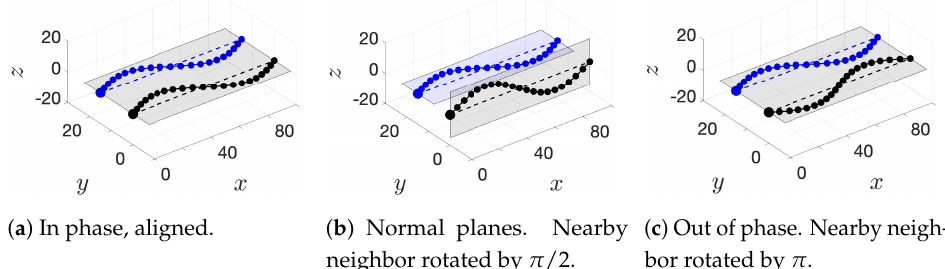
( a ) In phase, aligned. ( b ) Normal planes. Nearby neighbor rotated by π /2. bor rotated by π . Figure 5. Conceptual idea of configurations between neighboring flagella used to explore the role of phase and alignment. Centerline of each flagella is shown by a dotted line. Rotation of nearest neighbors is done by rotating about this centerline. Beat planes are represented by transparent rectangular shapes either at z = 0 or y = 0, depending on rotation angle. When these rotations are applied to groups of swimmers in a grid-like formation, the beat planes of neighboring swimmers will either parallel or normal to each other. For cylindrical and radial configurations of groups of swimmers, neighboring swimmers’ beat planes are rotated by an additional 2 π / m for m flagella to maintain circular